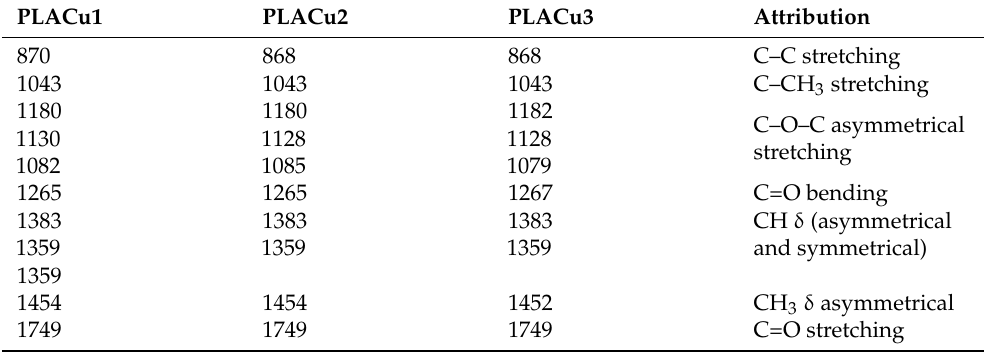
Figure 6. FT-IR spectra of PLA/Cu composites (samples PLACu1, PLACu2, PLACu3). Table 2. The attribution of the main absorption bands from the spectra of PLA and PLA-based com-